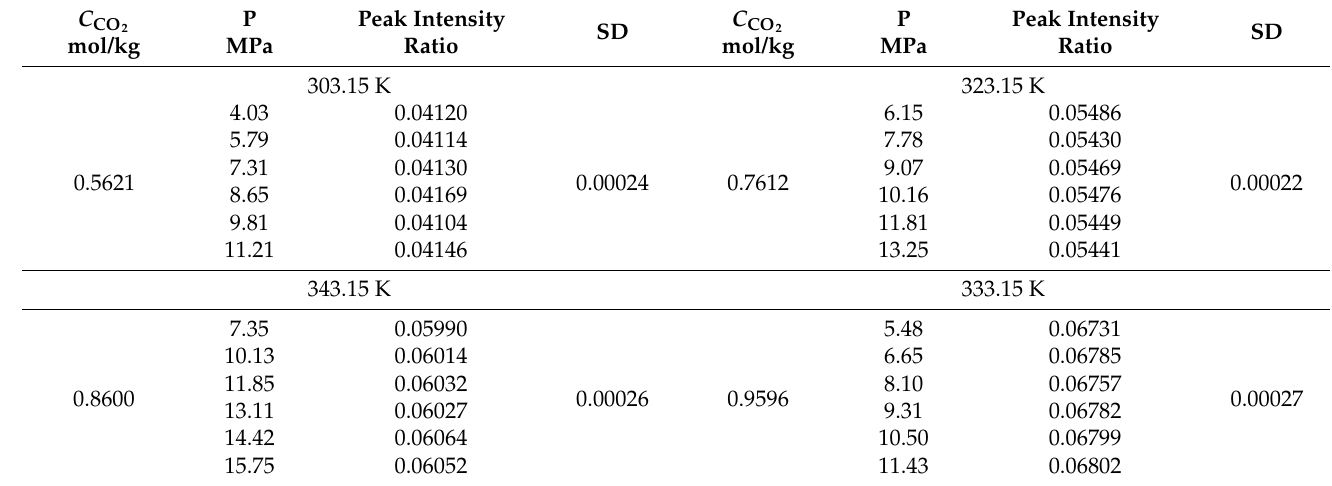
Table 3. The Raman peak intensity ratio of CO 2 + n -decane system at different pressures.